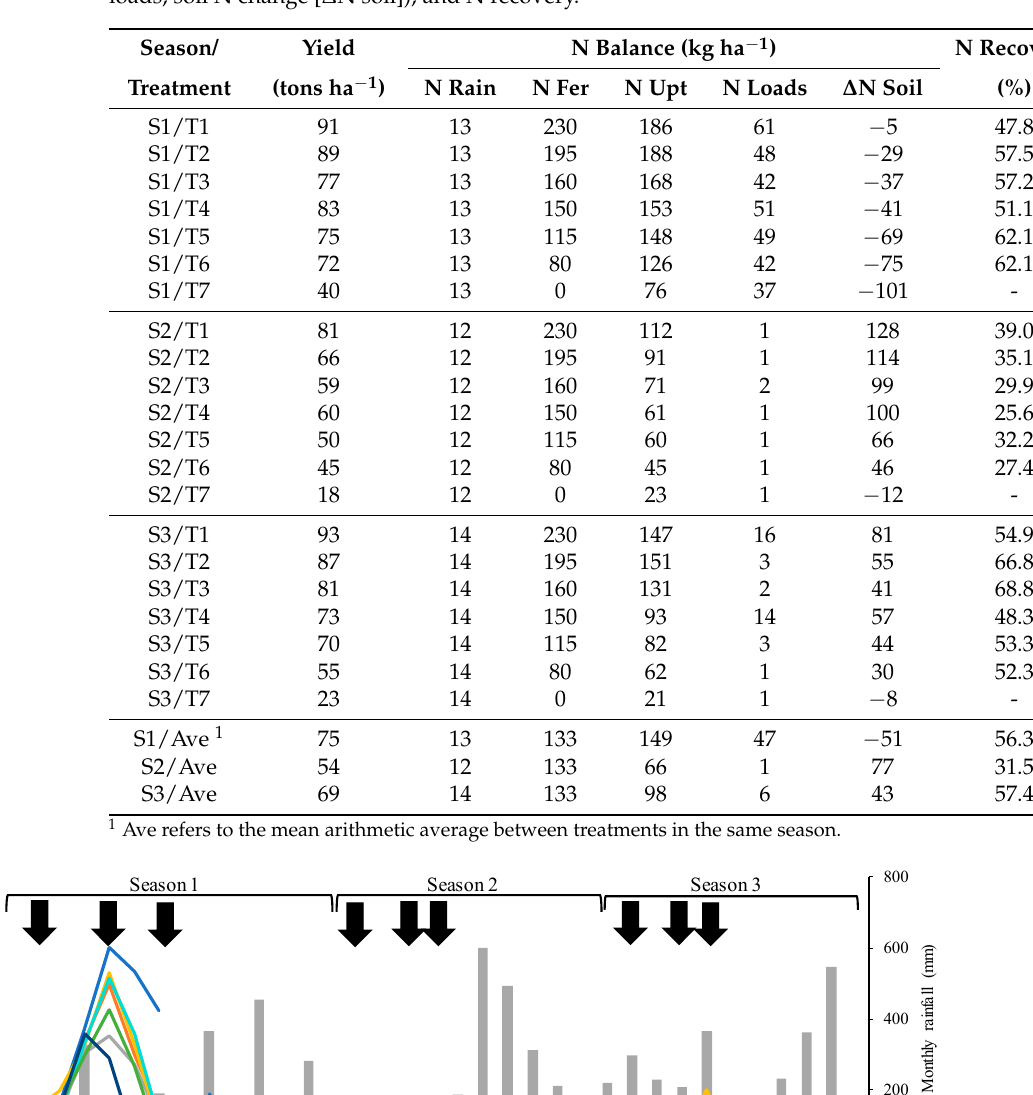
Table 7. Sugarcane yield (Yield), N balance (N rain, N fertilizer [N fer], N uptake by crops [N upt], N loads, soil N change [ ∆ N soil]), and N recovery.